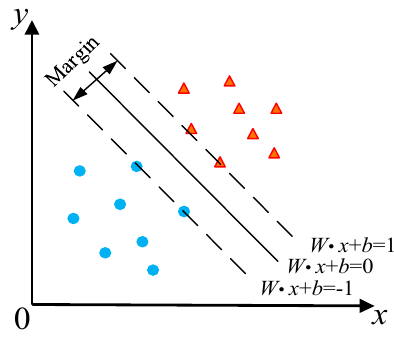
Figure 7. The classification principle of SVM.